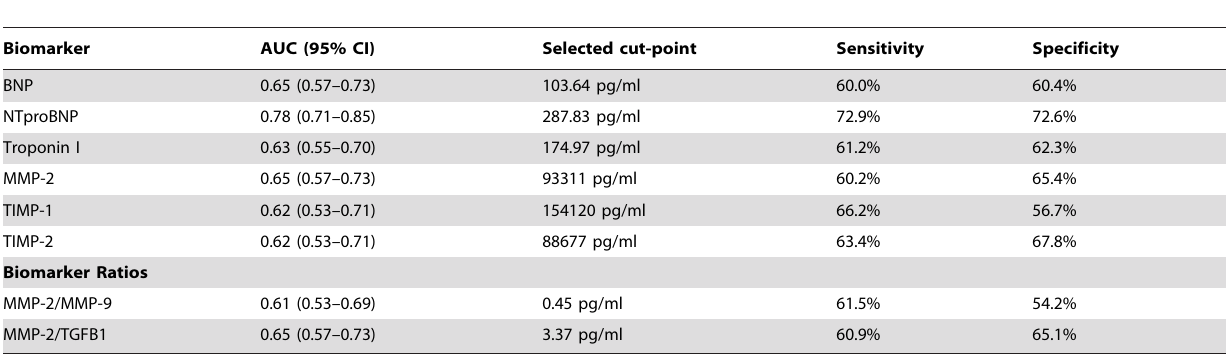
Table 3. Results of ROC analysis of selected markers for discrimination between Stage AB and CD among T. cruzi -infected